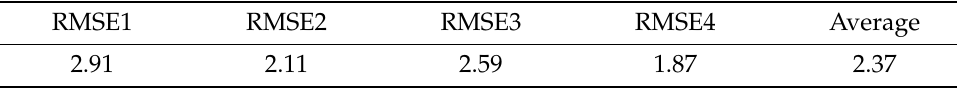
Table 4. RMSE values of the prediction (specific